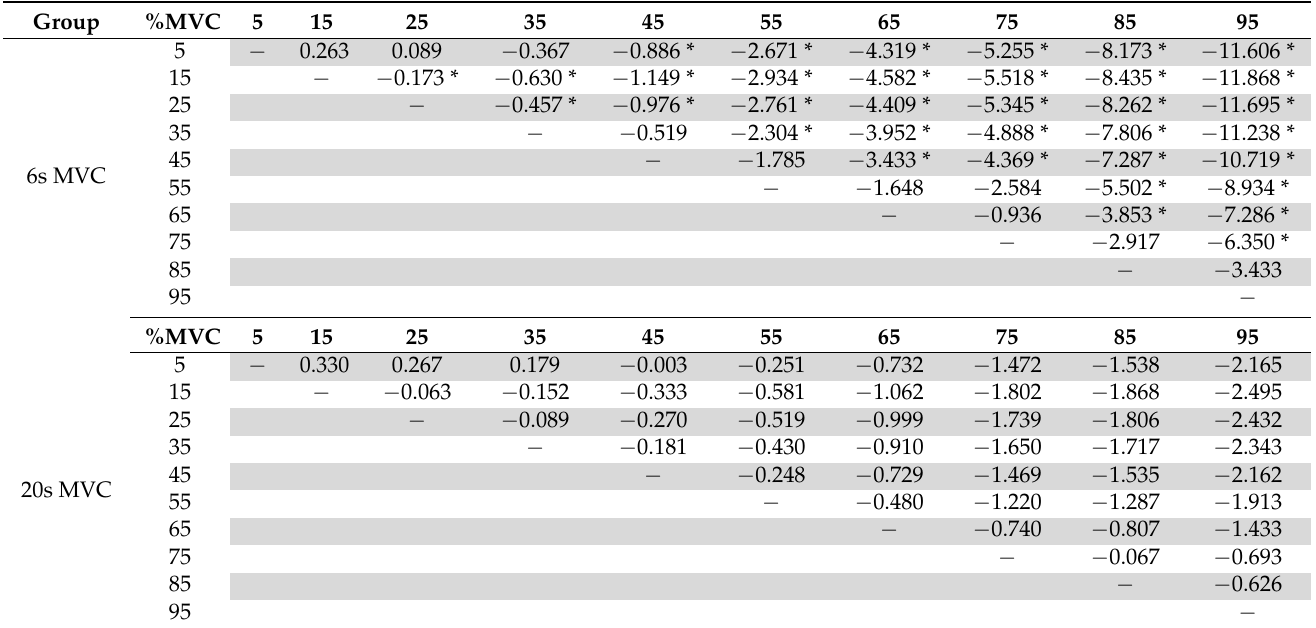
Table 2. Mean Differences in RMSE